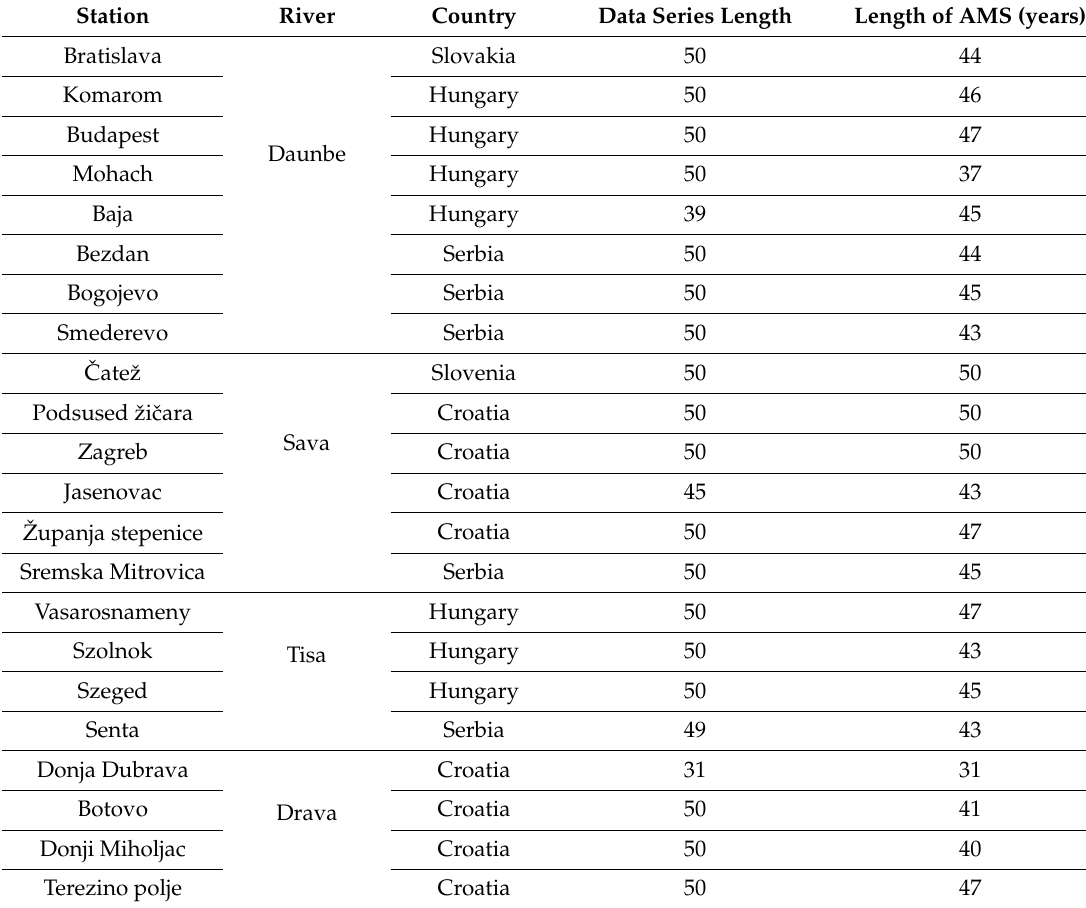
Table 1. Investigated station in the Pannonian